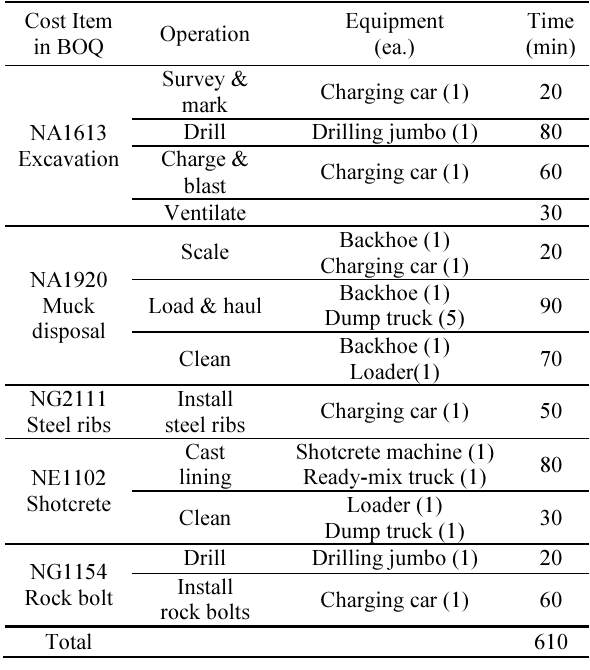
Table 2. Cost items and operations of Type-IV top